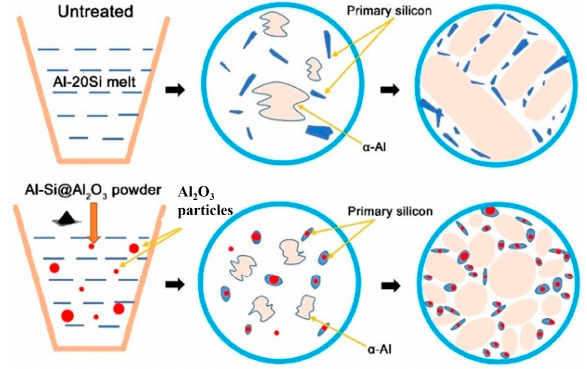
Figure 14. The re fi ning mechanism of Al–20Si@Al 2 O 3 powder. Figure 14. The refining mechanism of Al–20Si@Al 2 O 3